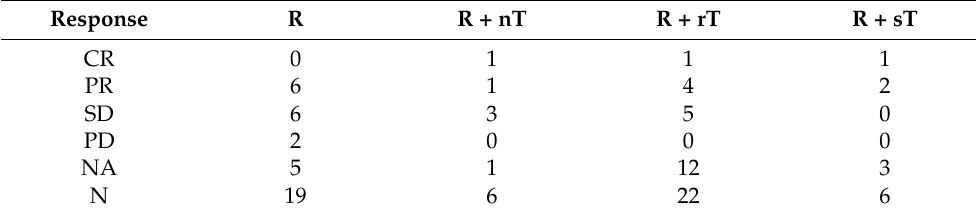
Table 3. Response to radiotherapy with/without concomitant TKIs in the definite irradiated lesions.